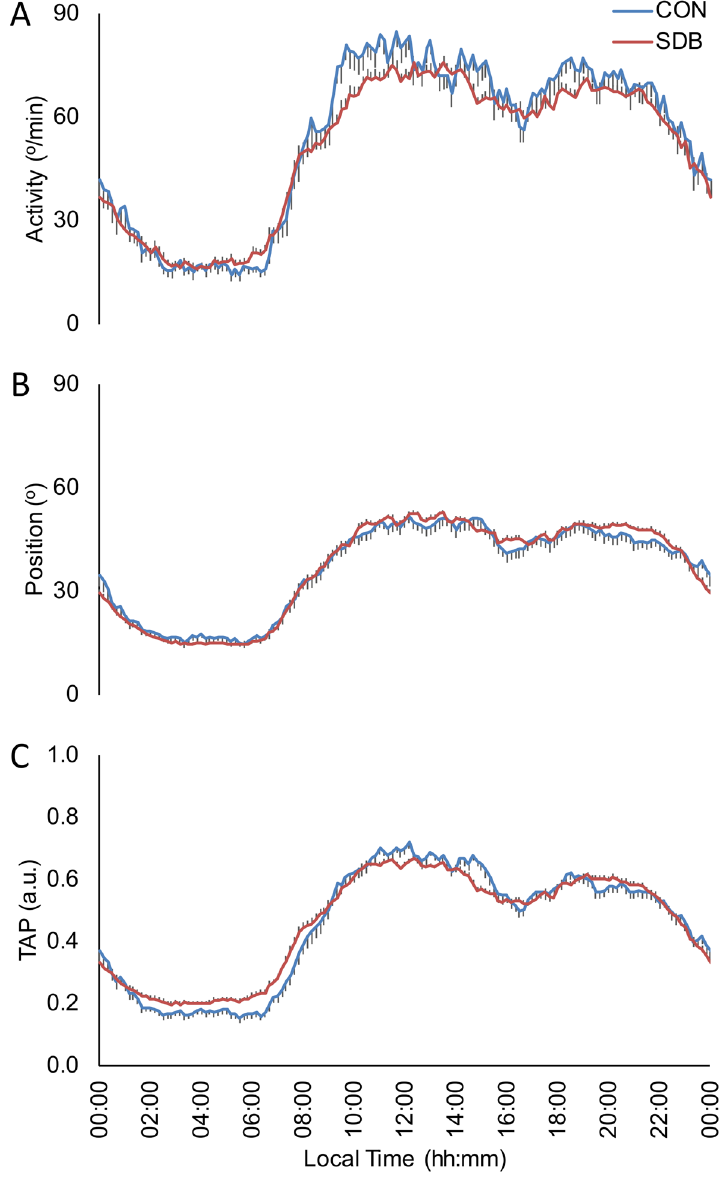
Figure 1. Mean waveforms for SDB patients (red line, n: 78) and control subjects (blue line, n: 32) for: ( A ) Activity (º/min), ( B ) Body Position (º) and ( C ) integrated variable TAP (a. u.). All data are expressed as mean ±